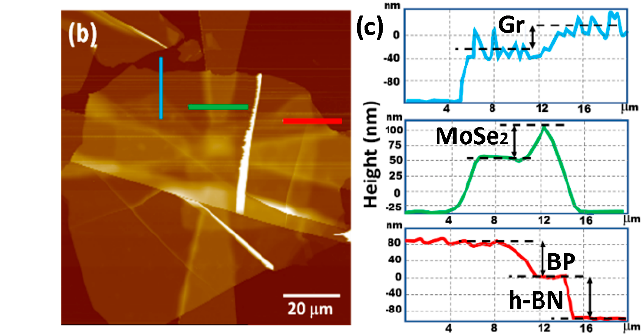
Figure 1. ( a ) Scanning electron microscopy (SEM) image (scale: 20 μ m), ( b ) atomic force microscopy (AFM) image (scale: 20 μ m) of h-BN-covered Gr/n-MoSe 2 /p-BP heterostructures, and ( c ) the corre- sponding thickness of each multilayer determined via topographic analysis.